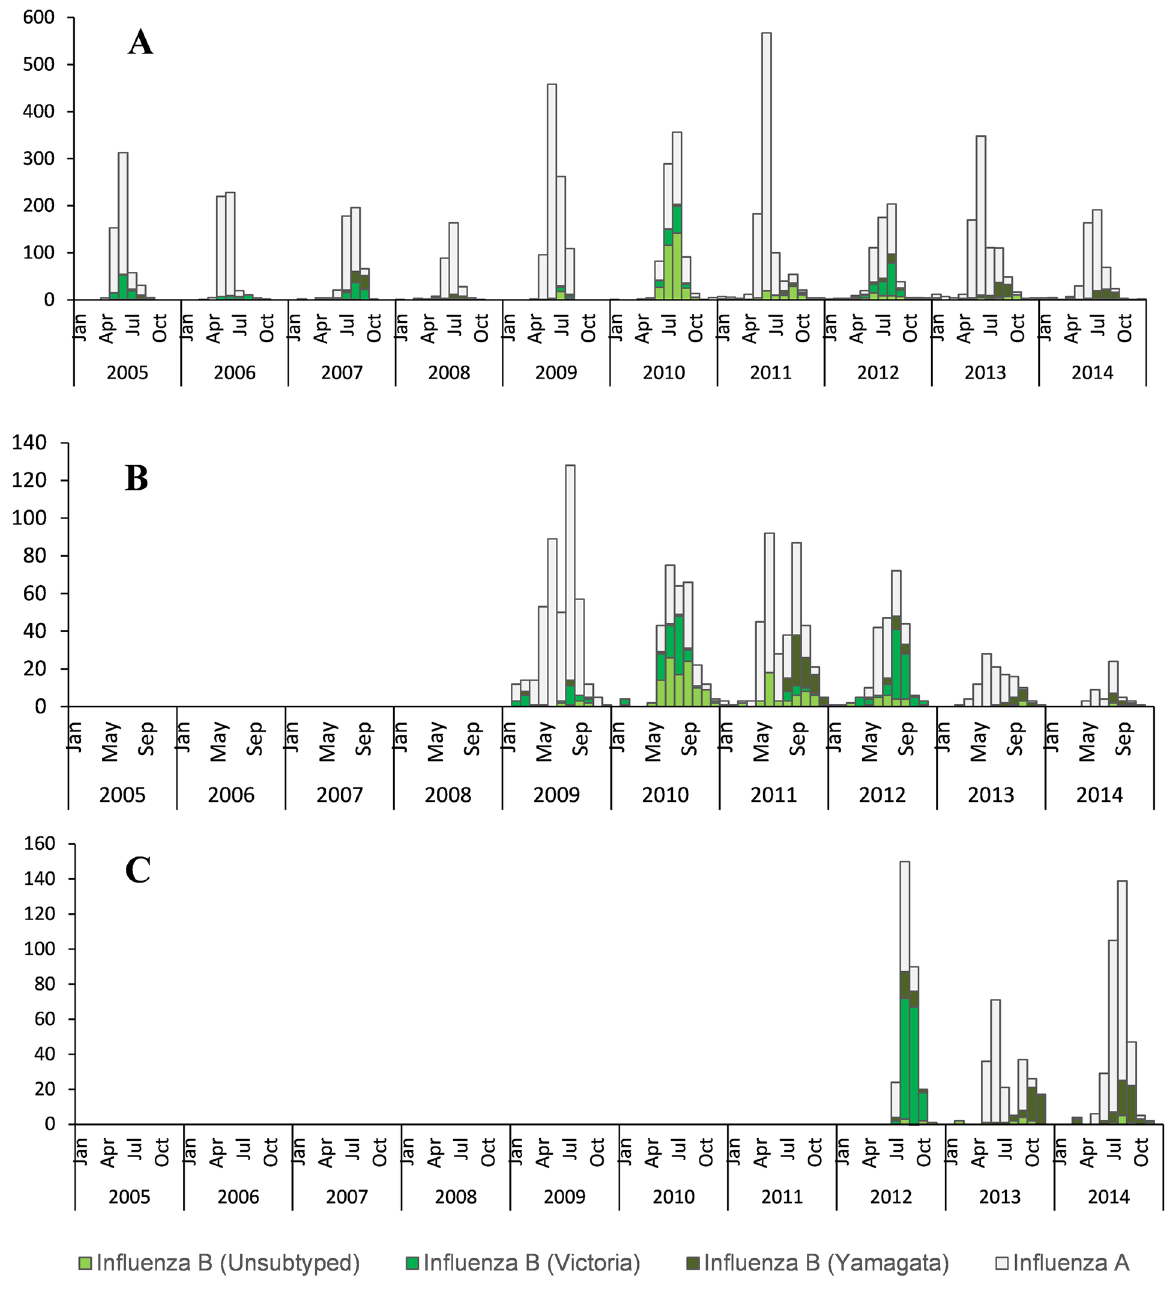
Fig 1. Monthly number of influenza-positive specimens in South Africa. ( A ) Viral Watch program (2005–2014), ( B ) Severe acute respiratory illnesssurveillance program (2009–2014), and ( C ) Influenza-like illnesssurveillance program in public healthclinics (2012– 2014).